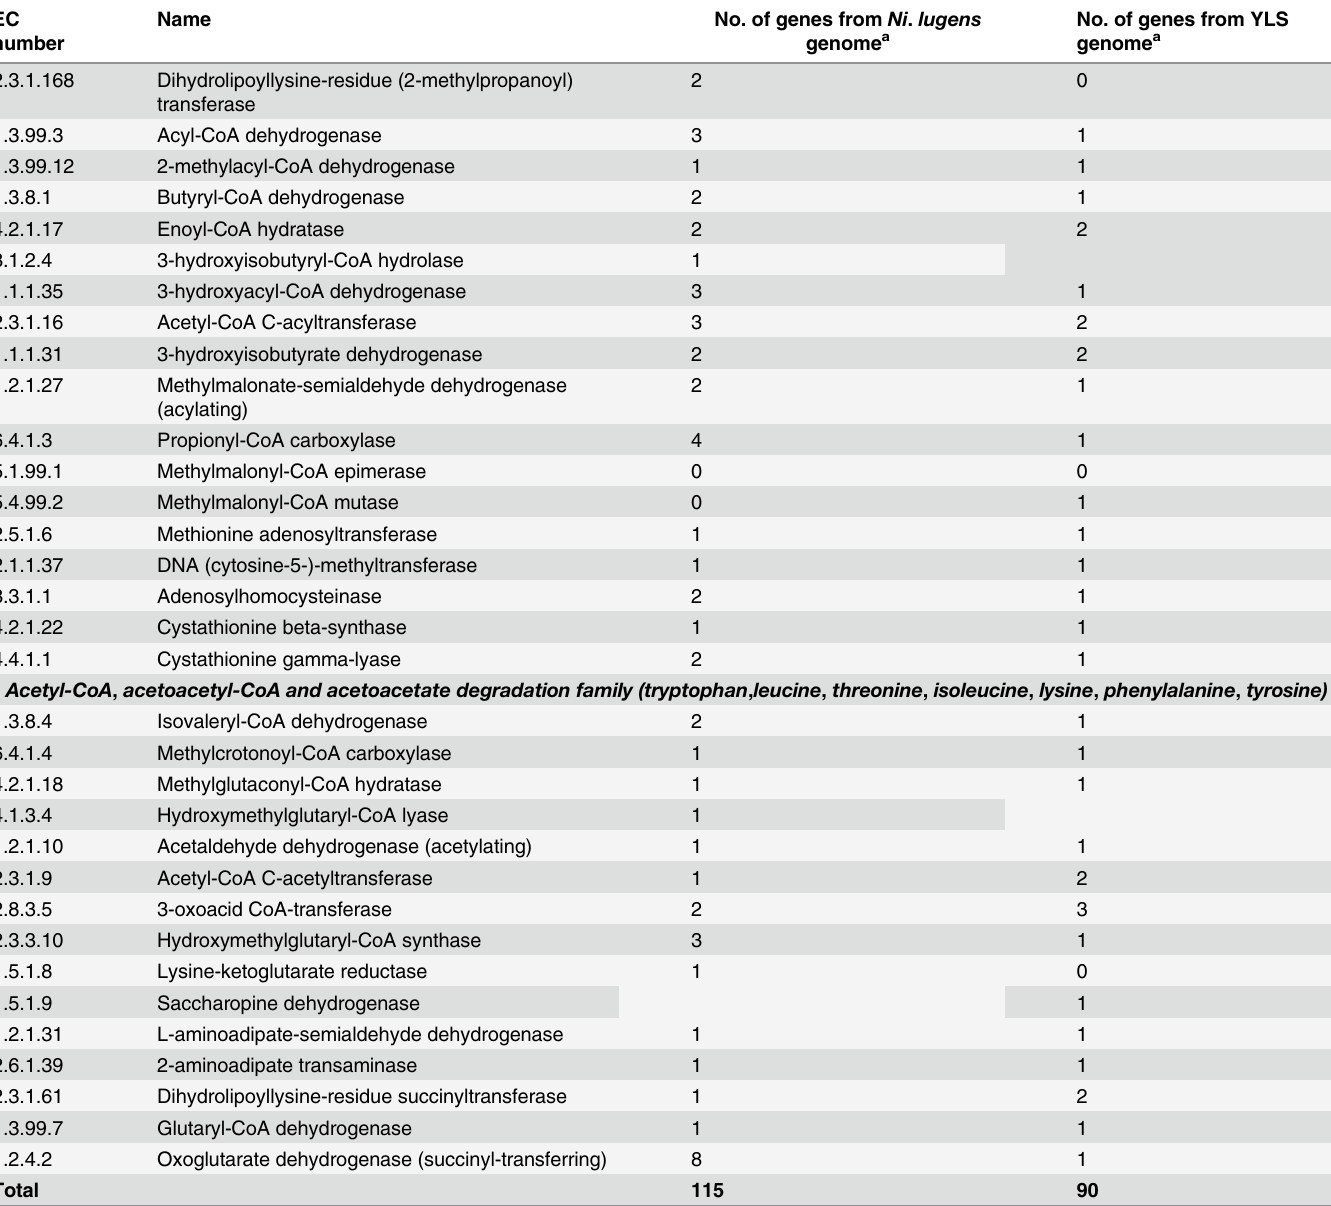
The 5'- and 3'-RACE fragments of lkr/sdh were amplified according to the manual of SMARTer specific primers and universal primers. After obtaining the full-length cDNA, a pair of primers (Table 2) was designed to verify the complete open reading frame (ORF). The confirmed se- quence ( Nllkr/sdh ) was submitted to GenBank